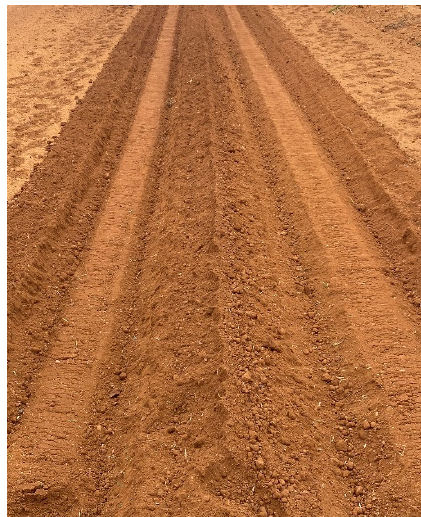
Table 3. Test factor coding.